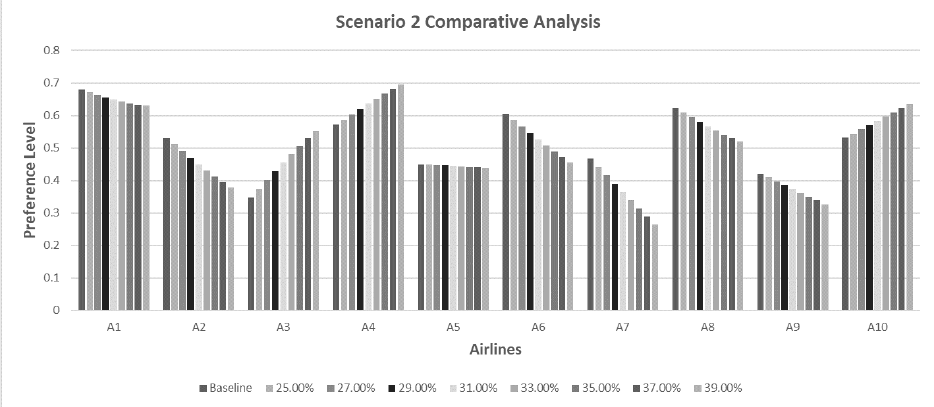
Fig. 5. Comparison results of Scenario